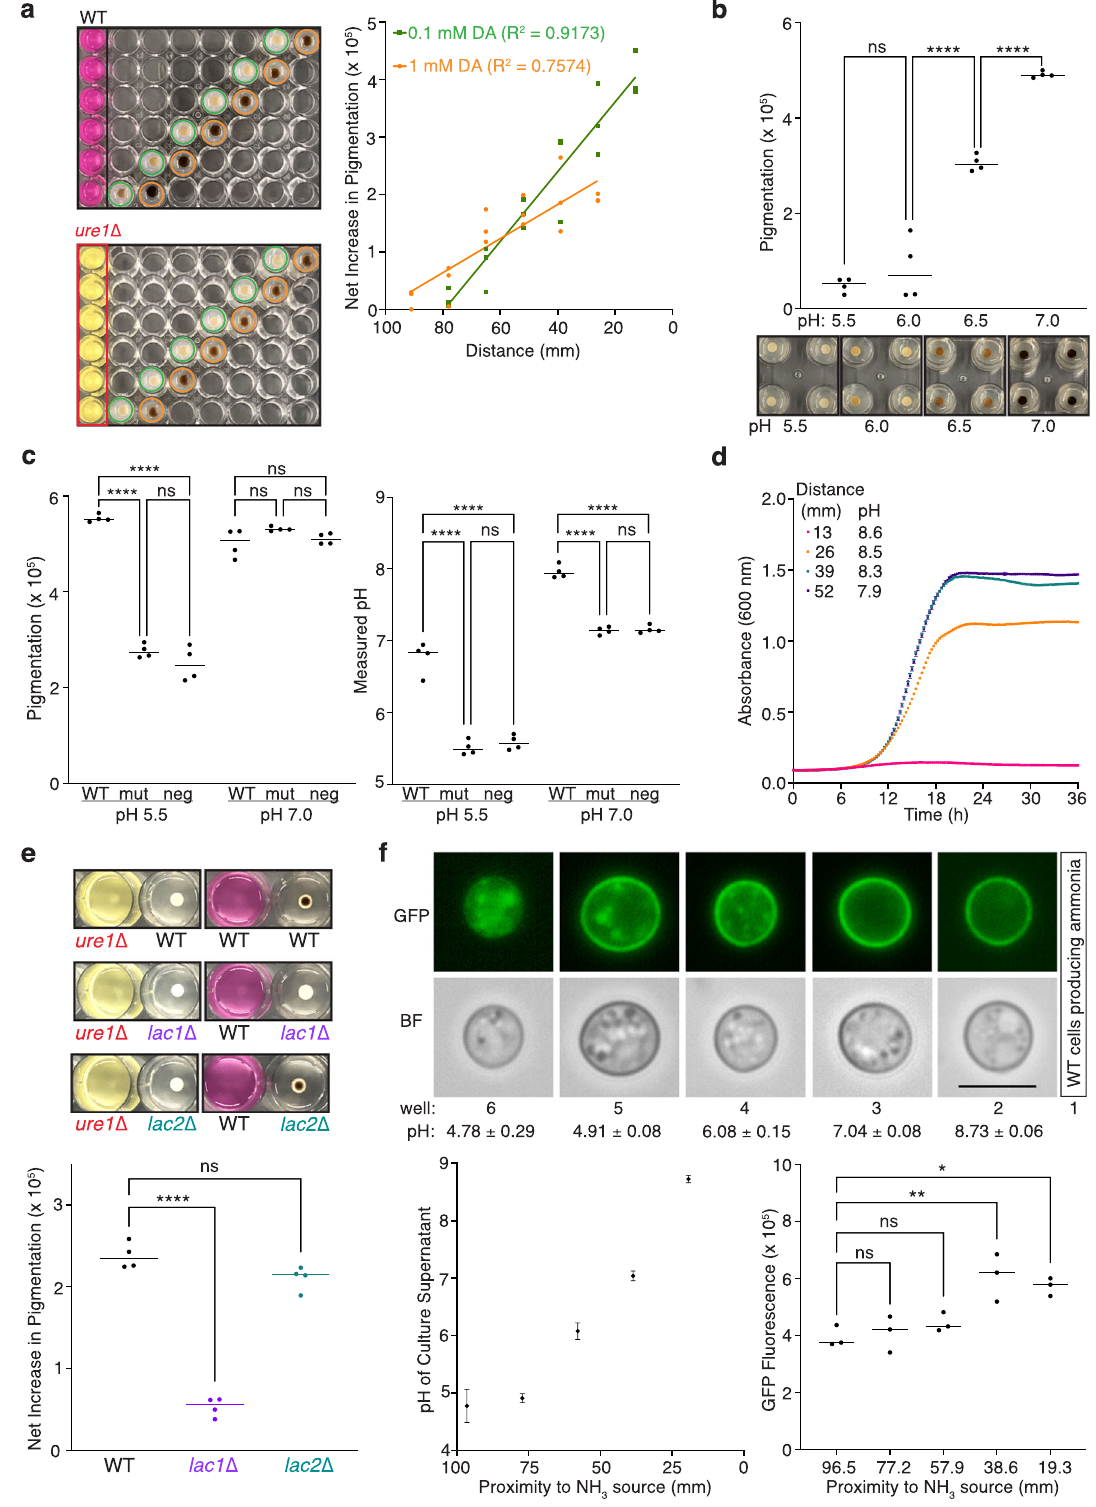
fi rst vertical column of wells, to which WT cells in urea broth were added. Following incubation at 30 ˚ C for 24h, cellular localization of GFP-laccase 1 was visualized by fl uorescence microscopy of live cells.